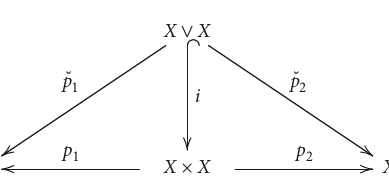
Figure 14: A commutative diagram.